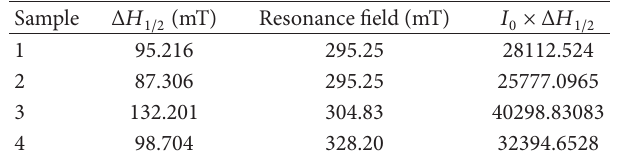
T 1: A summary of parameters aer �tting (1) and (2) to the ESR data for all FePt